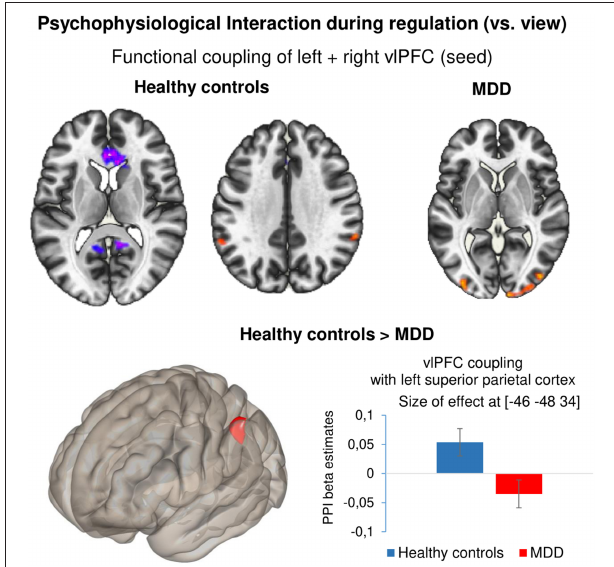
FIGURE 4 | Psychophysiological interaction during regulation. Results of the generalized psychophysiological interaction analysis for the contrast ‘regulate – view’ with bilateral vlPFC as seed. Healthy controls showed increased coupling between the seed region and bilateral superior parietal cortex and negative coupling between the seed and ACC as well as PCC. Patients showed positive coupling between the seed and bilateral occipital cortex. Compared with healthy controls, patients with depression showed significantly reduced coupling between the bilateral vlPFC and left superior parietal cortex. All results are reported at p < 0.001 voxel threshold and p < 0.05 FDR-corrected at cluster level. Bar plots indicate size of effect (beta values) at the voxel showing the maximum coupling